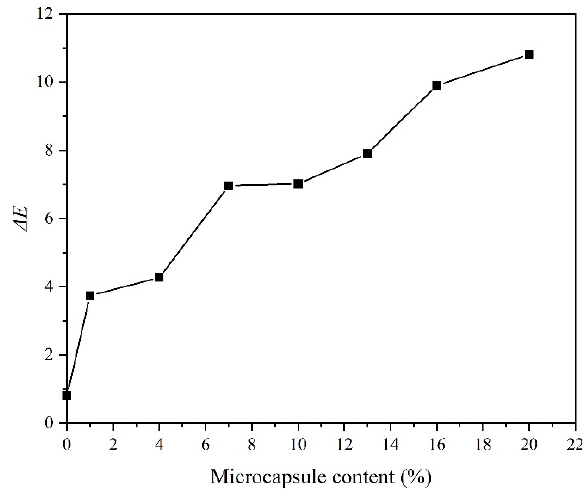
Figure 6. Effect of the microcapsule content on color difference of the coatings. Table 5. Gloss of the coatings with different microcapsule content.